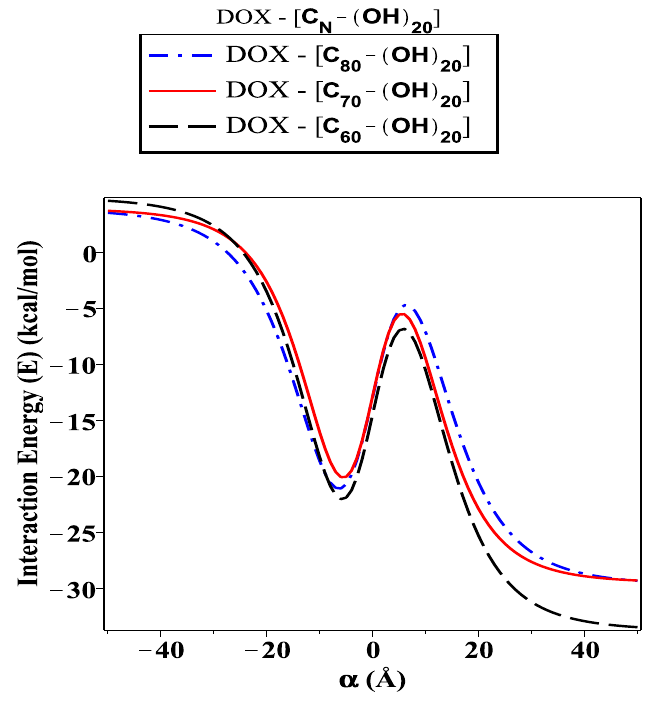
Figure 6. Interaction energy ( E ) arising from DOX molecule as tow-connected spheres, each as an arbitrary point interacting with fullerene derivatives (C N -[OH] 20